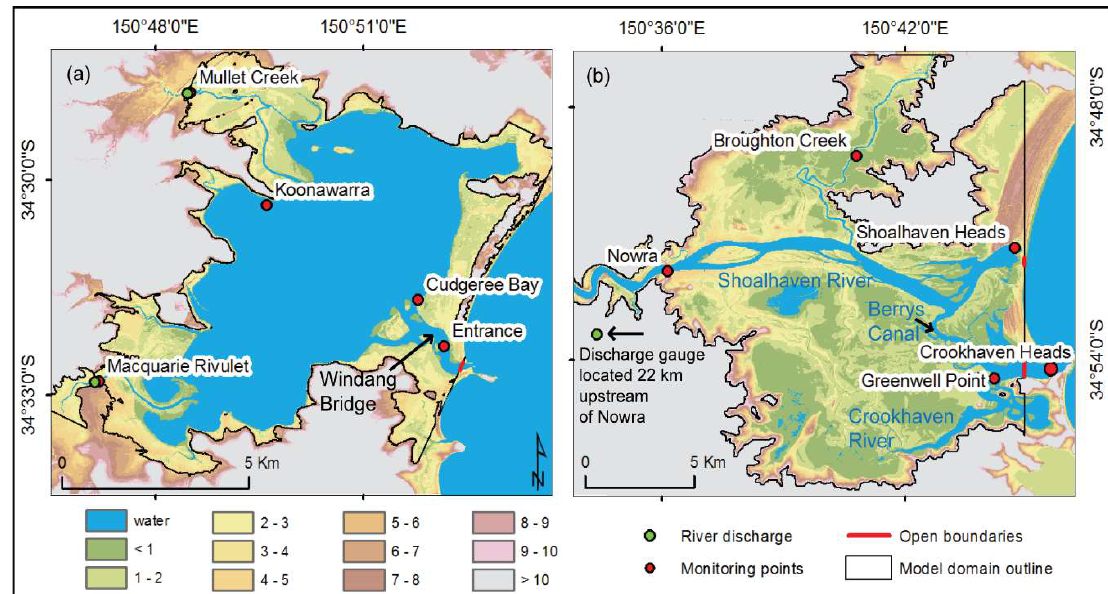
Figure 1. Topography and model setup at Lake Illawarra ( a ) and the Shoalhaven Estuary ( b ). LiDAR-derived topographic data of the floodplain is presented in m Australian height datum (AHD). Hydrodynamic model domains (black outline), open boundaries (red lines), river discharge locations (green dots) and monitoring points (red dots).